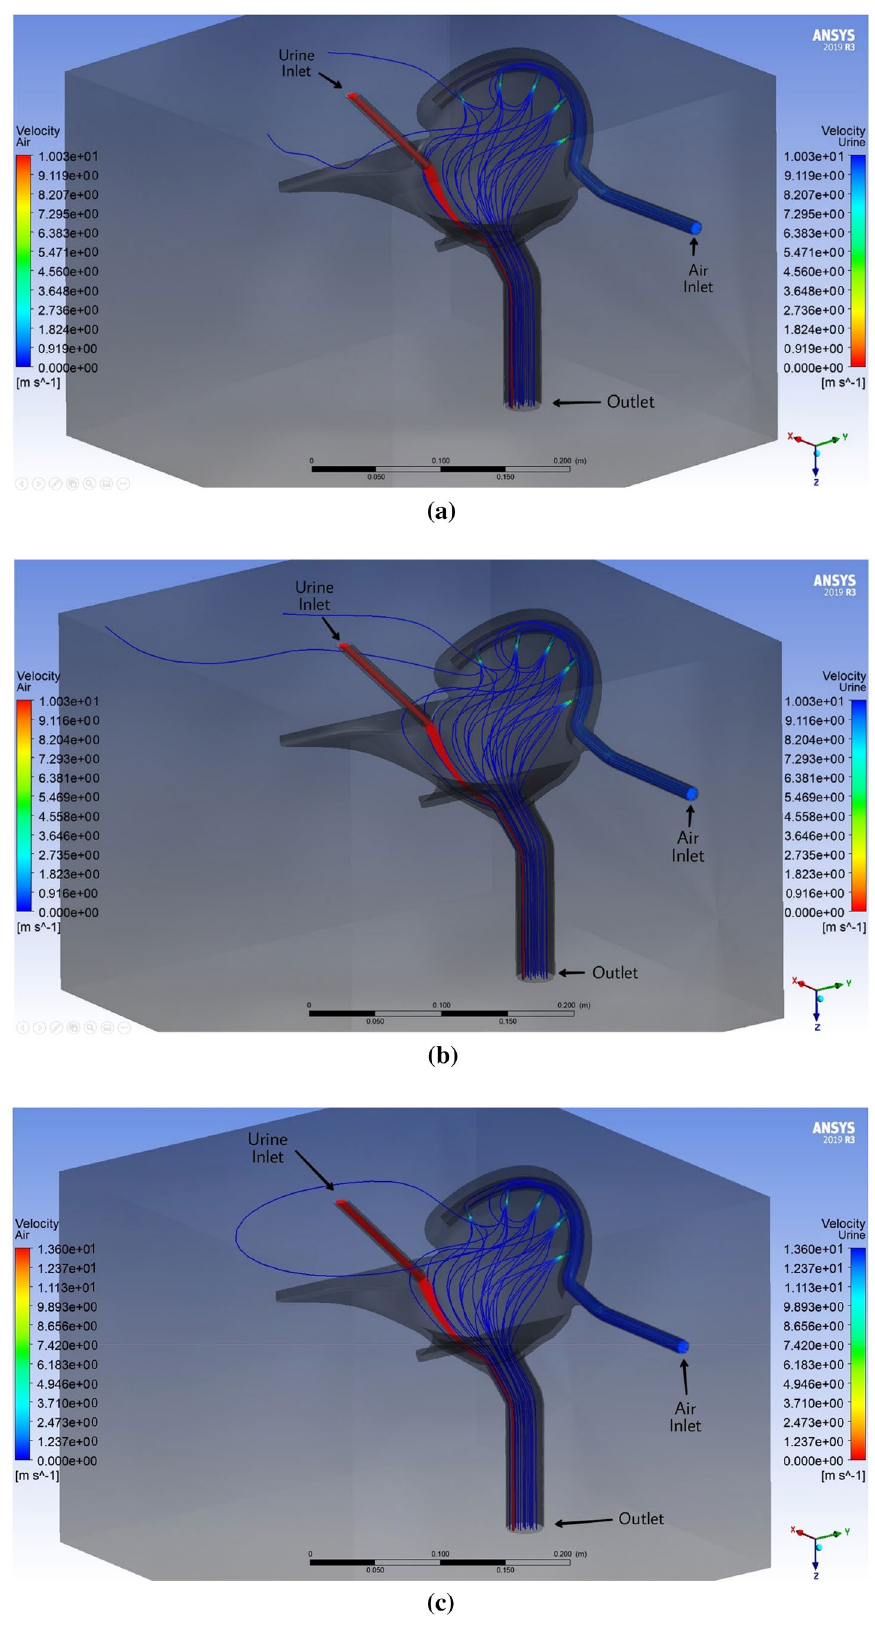
Fig. 18 The air flow simula- tions through nozzles provided with the urine funnel are done for three different conditions such as a for Mars gravity (3.721 m/s 2 ), b for the Moon gravity (1.62 m/s 2 ), c for the zero—or microgravity i.e., the space gravity. The urine is flushed with air at a high veloc- ity around 8 m/s towards the urine storage. The CFD analy- ses are carried out to study flow patterns of (i) air through nozzles of AFFS, and (ii)